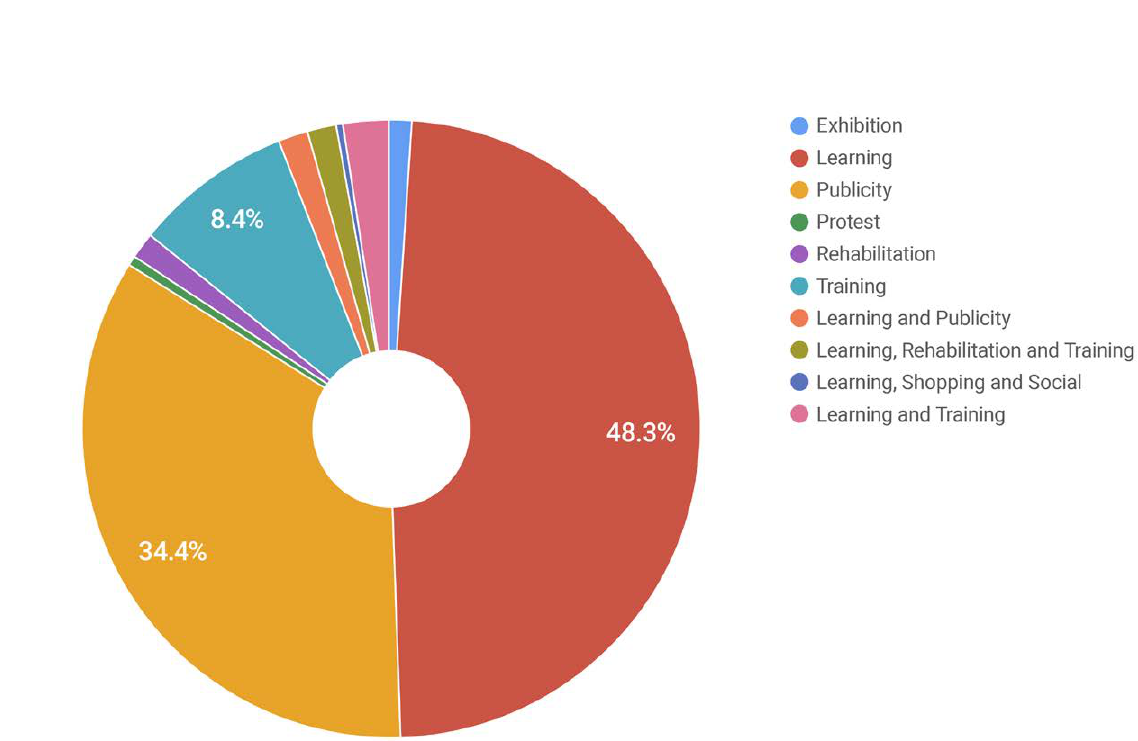
Chart 1 (this page, top): Domain Categorisation, Serious games domain categories. Source: Author. Chart 2 (this page, bottom): Purposes, serious games purpose categories. Source: